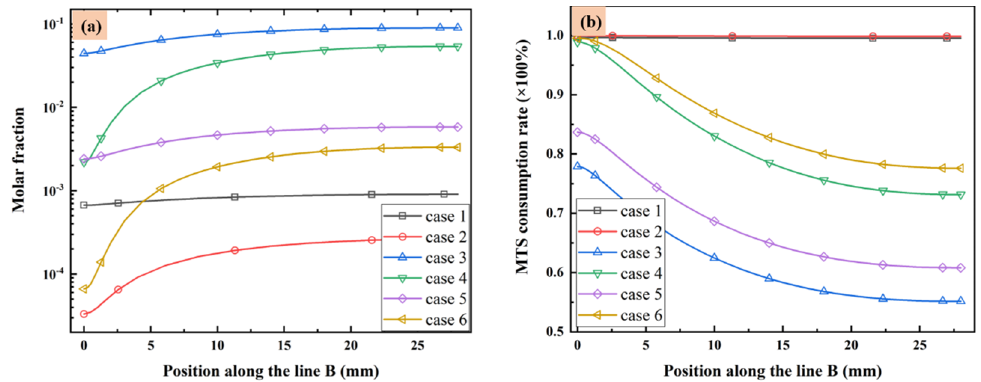
Figure 2. Velocity of the gas phase above the susceptor: ( a ) case 1 and case 2; ( b ) case 3 and case 4; and ( c ) case 5 and case 6.